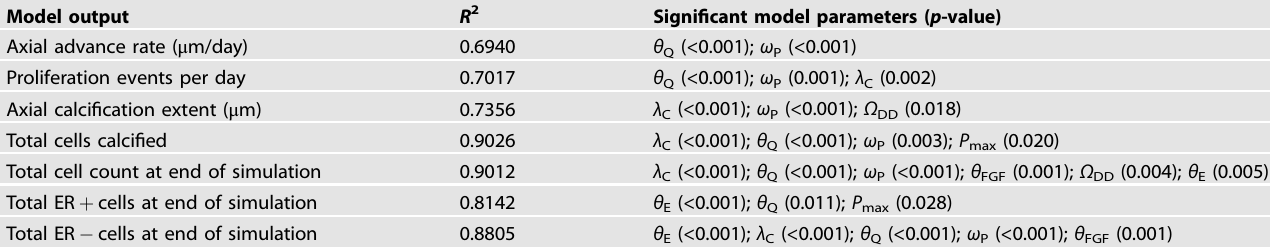
Fig. 4 Axial invasion over time from selected simulations. Each simulation run was input with a unique set of parameter values determined by LHS (see Table 1, Supplementary Table S1). a Without dedifferentiation, axial invasion is observed to arrest when the stem cell population in the leading edge becomes depleted; as can be seen by curves fl attening at higher times. b Growth arrest is not seen when the dedifferentiation pathway is active. Only a subset ( n = 10) of simulations are shown in each panel for ease of visibility; matching colors do not indicate a relationship between curves in each Table 3. Linear regression analysis of global sensitivity analysis with the dedifferentiation pathway enabled.